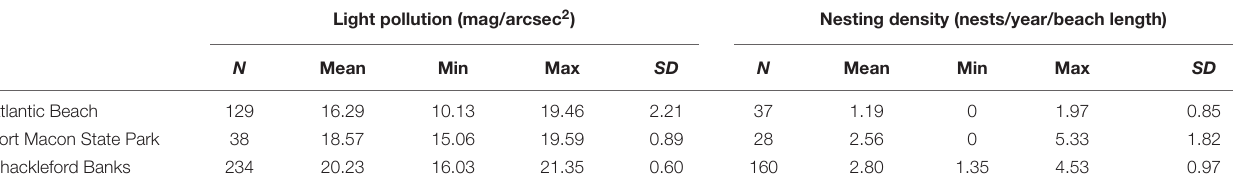
TABLE 1 | Sample size (N), average, minimum, maximum, and SD of light pollution (mag/arcsec 2 ) and nesting density (nests/year/beach length) on Atlantic Beach, Fort Macon State Park, and Shackleford Banks, NC. Low mag/arcsec 2 values indicate high light pollution. Light pollution (mag/arcsec 2 ) Nesting density (nests/year/beach